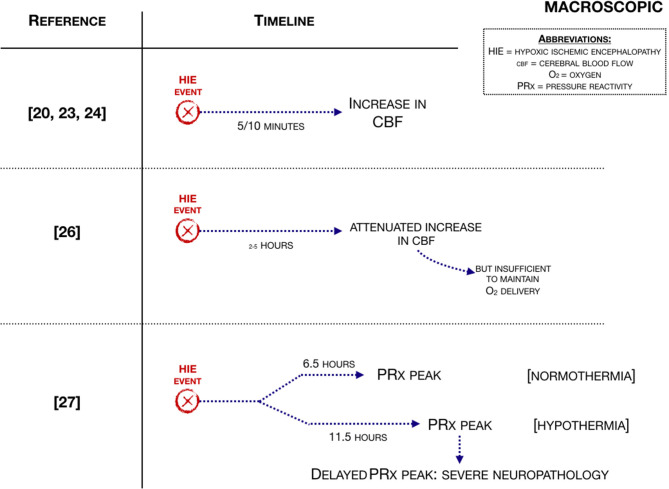
Macroscopic hemodynamic changes associated with an HIE event (21, 24, 25, 27, 28).